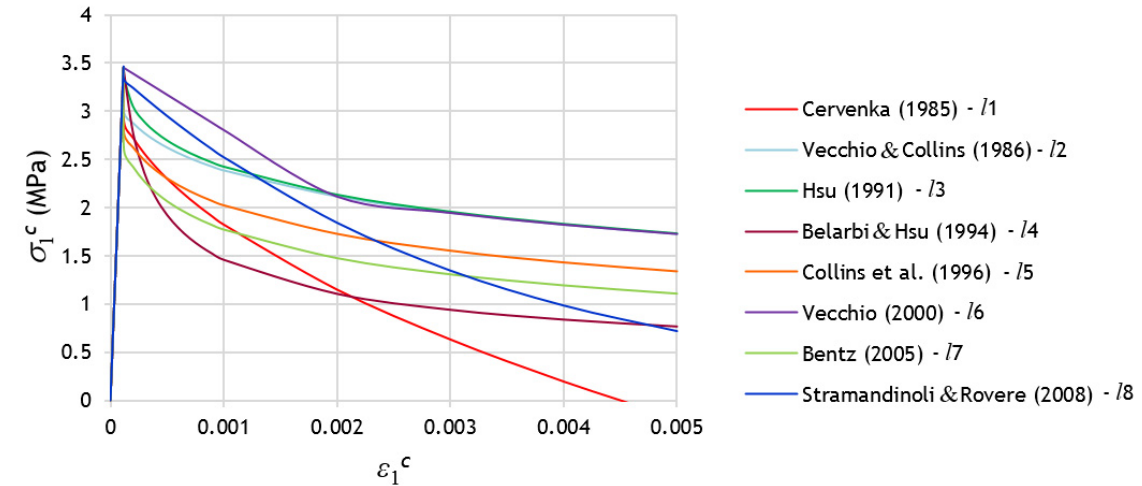
Figure 5. Comparison between the smeared constitutive laws. After the peak stress, namely for the descending branch, Figure 5 shows high vari- ability between the σ — ε curves. In spite of the peak stress coincides for all the curves, it should be noted that the referred variability will influence the calculation of the cracking torque and corresponding twist with the GSVATM. This is because, as previously referred, the tensile stress σ c computed from Equation (31) represents an average stress since the real 1 stress diagram along the effective tie’s thickness is not uniform due to the strain gradient (Figure 3). The representative concrete tensile stress in the GSVATM ( σ c ) does not coincide 1 with the maximum tensile stress. Hence, the strain ε c corresponding to the effective crack- 1 ing torque in the M T — θ curve computed with the GSVATM does not coincide with the strain ε cr corresponding to the peak stress in the smeared σ — ε curves for tensile concrete. for tensile concrete, computed with the GSVATM, are presented. The highlighted point in the curves (with marker “ ”) corresponds to the effective cracking torque, which is reached for a strain ε c > ε cr , i.e., in the descending branch of the smeared σ — ε curve for 1 tensile concrete. This explains why different smeared σ — ε curves for tensile concrete Figure 6. Location of the effective cracking point. incorporated in the GSVATM will lead to different coordinates for the cracking torque (cracking torque and corresponding twist).